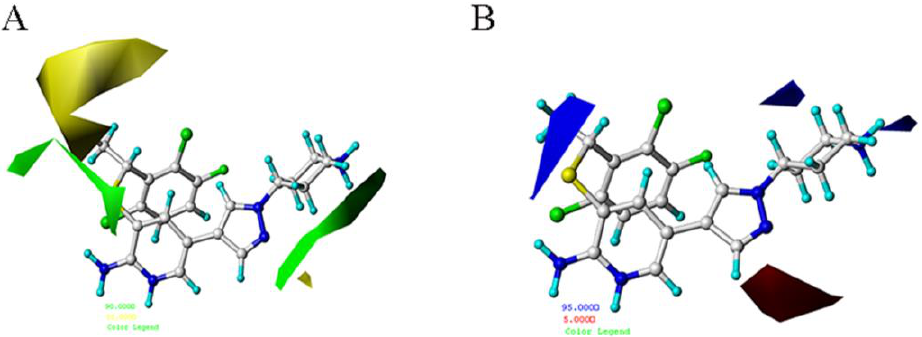
Figure 7. The docking-based CoMFA STDEVCOEFF contour maps ( A ) The steric field. ( B ) The electrostatic field.